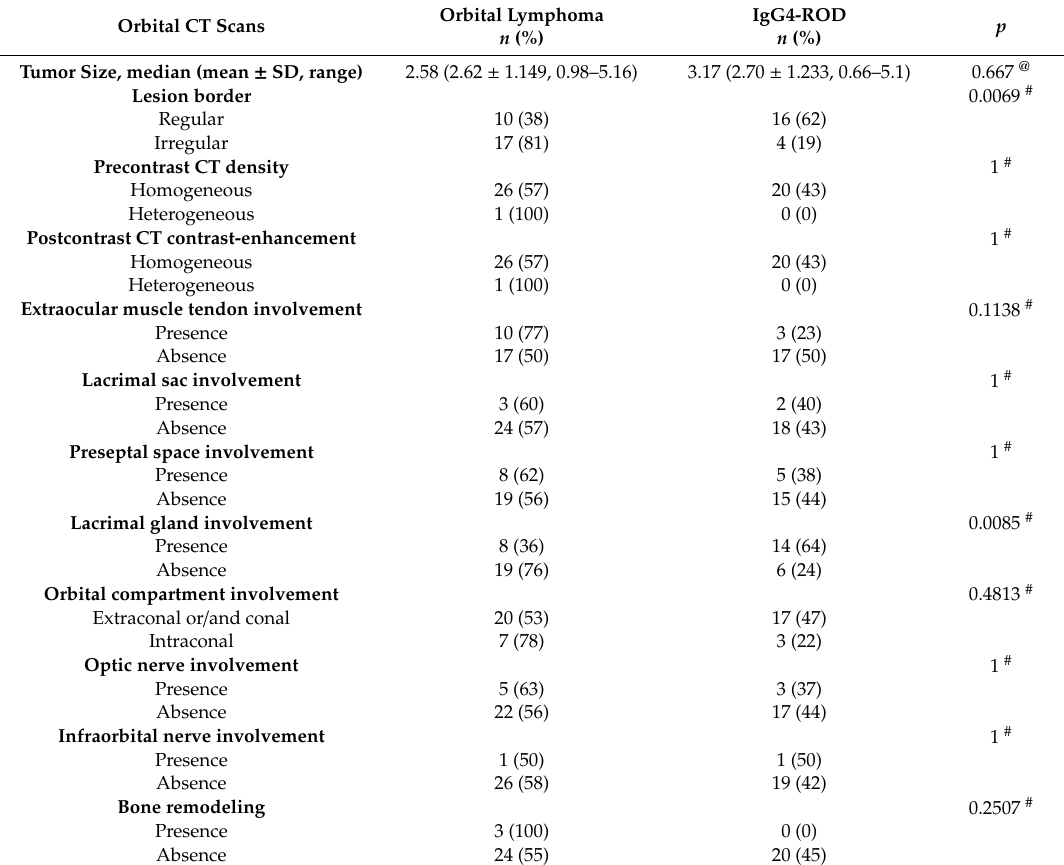
Table 1. Computed tomography (CT) features of 47 tumors among the 25 patients with orbital lymphoma or immunoglobulin G4-related orbital disease (IgG4-ROD) on prebiopsy orbital CT scans.